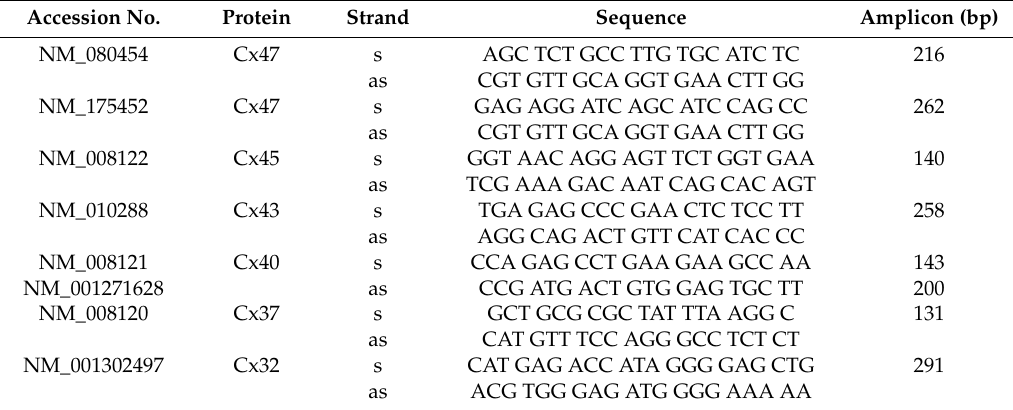
Table 1. Primer sequences used in this